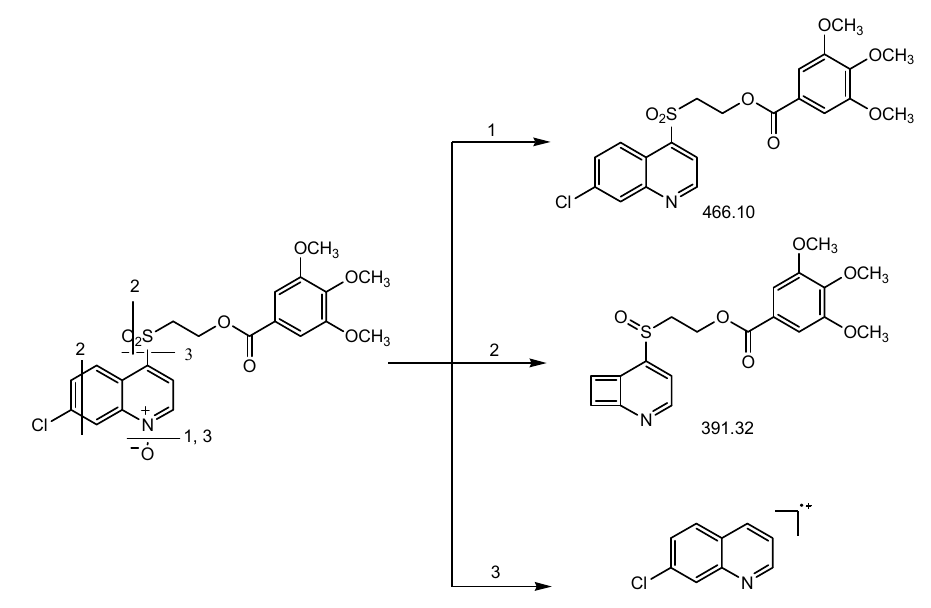
Figure 7. Mass spectrum of 67 and proposed fragmentation patterns.